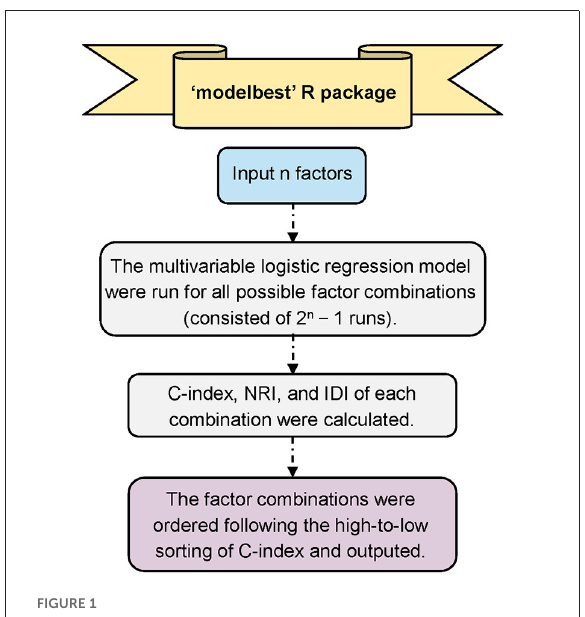
FIGURE1 Overall workflow of Modelbest. C-index, Harrells concordance index; NRI, net reclassification index; IDI, integrated discrimination index.